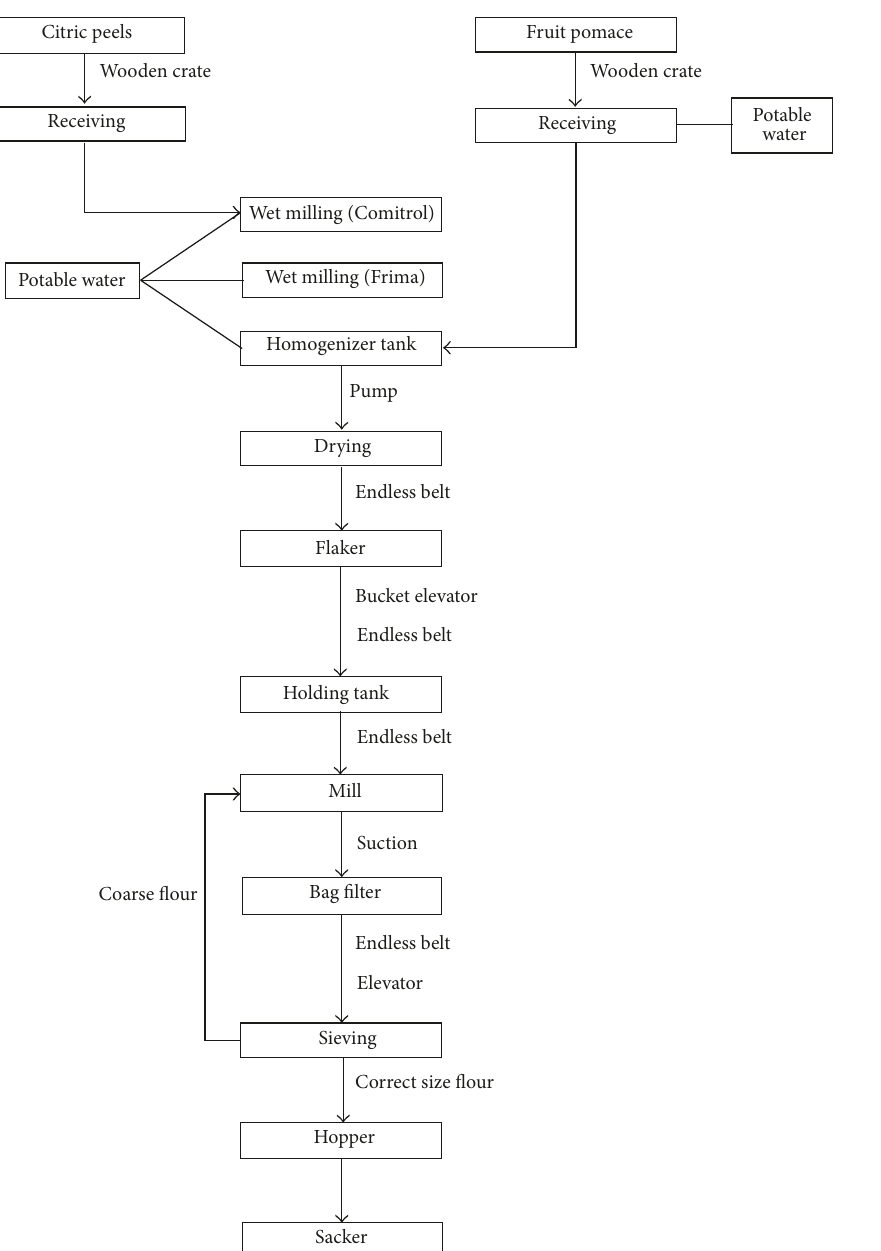
Figure 1: Schematics of the production process to obtain the analysed fruit fibres from residues of the juice industry.